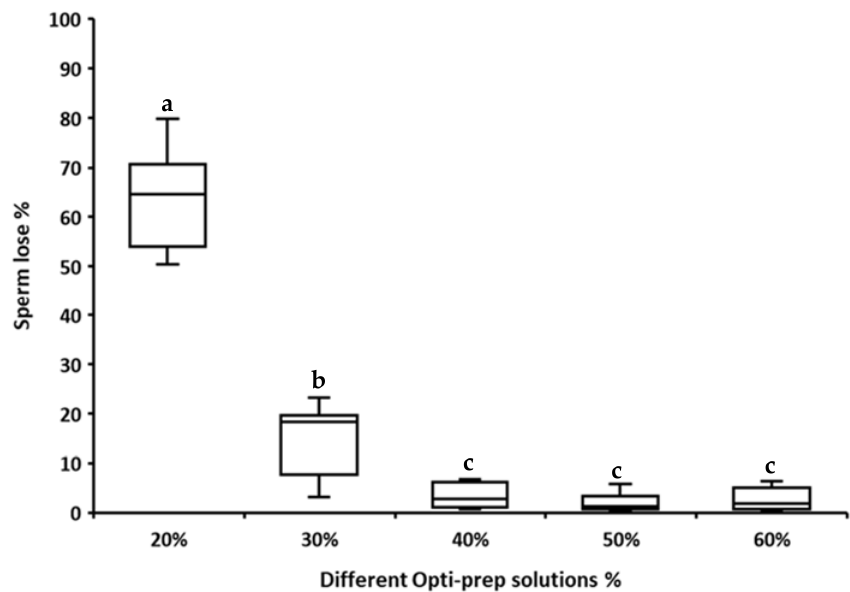
Figure 3. Percentage of sperm lost through the cushion layer after centrifugation at 1000 × g for 20 min using cushion layers consisting of different percentages of Opti-prep TM (20–60%). The lines (“whiskers”) on the top and bottom of each box show the range of sperm lost, and the horizontal line on each box represents the median ( n = 6 stallions). Different letters indicate boxes that differ significantly ( p ≤ 0.05).